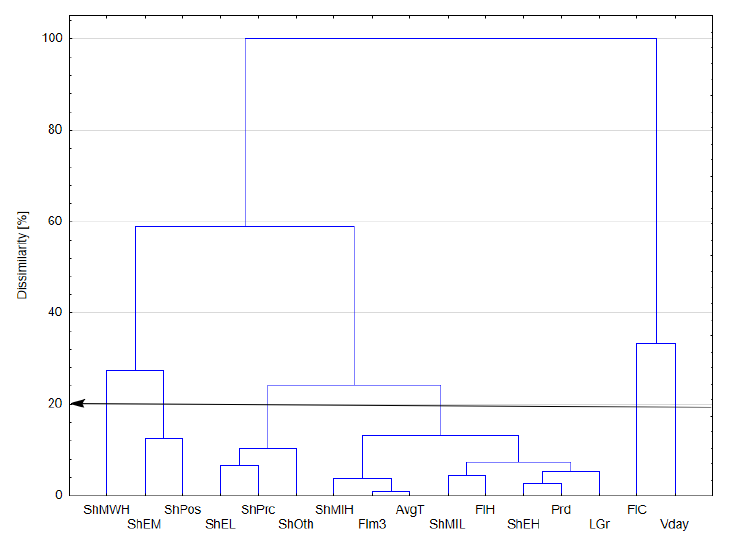
Forests 2023 , 14 , 165 Figure 2. Dendrogram of variables for machine A. Figure 2. Dendrogram of variables for machine A.